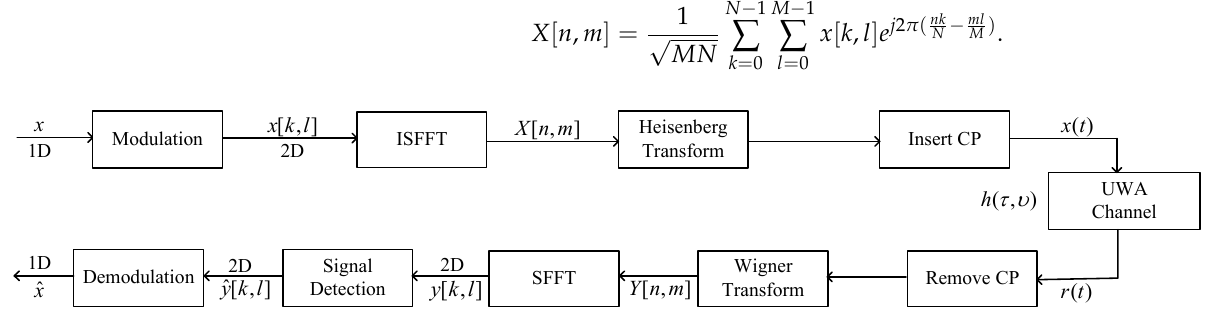
Figure 1. Block diagram of the UWA OTFS